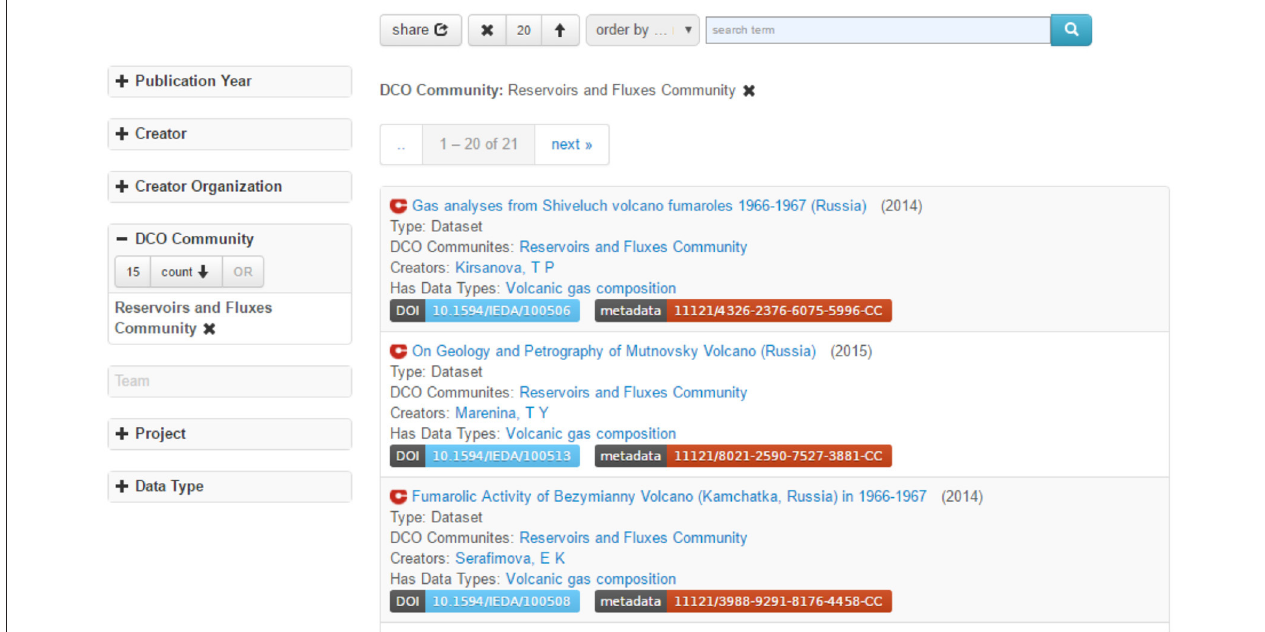
FIGURE 7 | DCO dataset records imported from external data